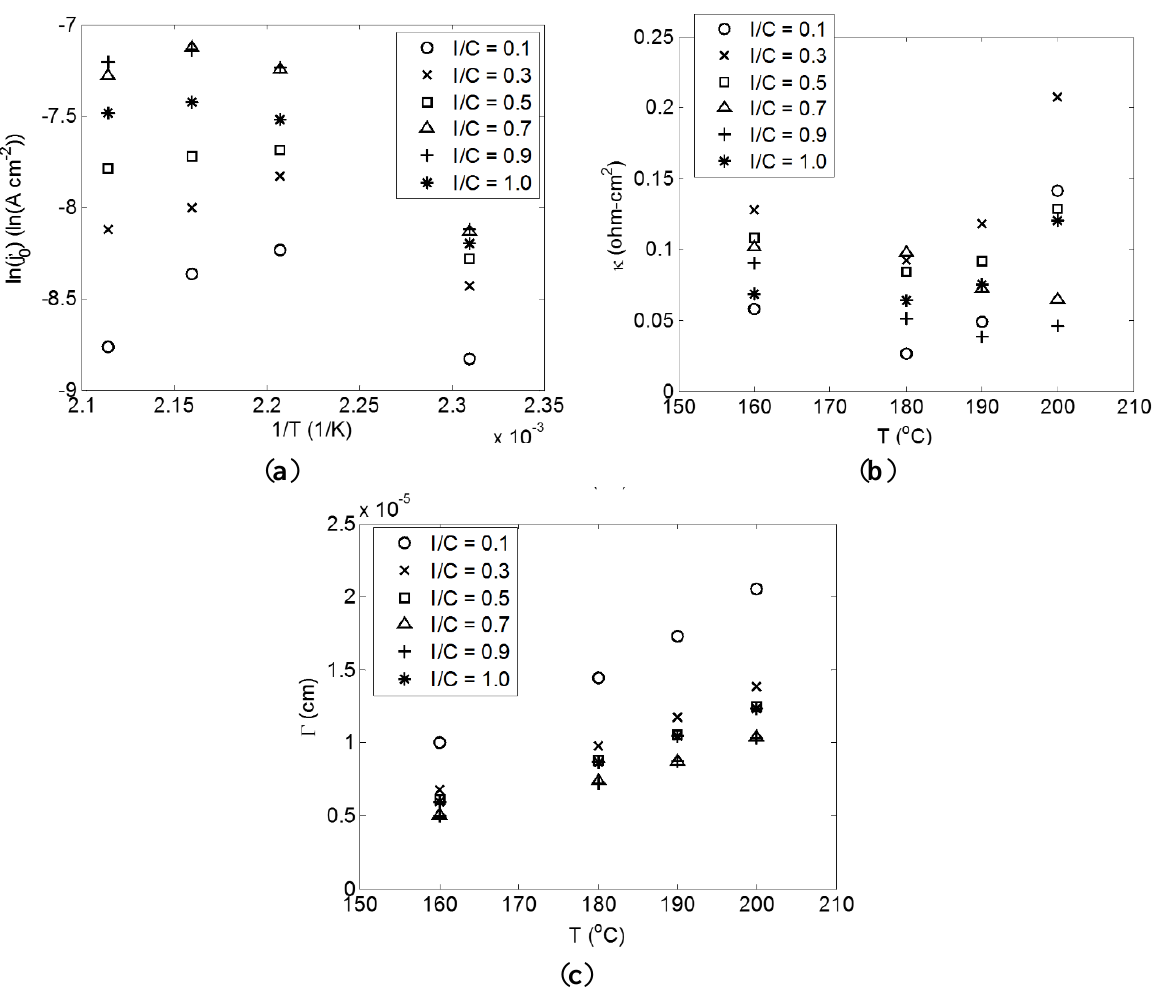
Figure 5. Correlation parameters as a function of temperature for I/C ratios. Inset ( a ) represents the exchange current density parameter, resistance parameter, κ, and ( c ) represents the geometric parameter,